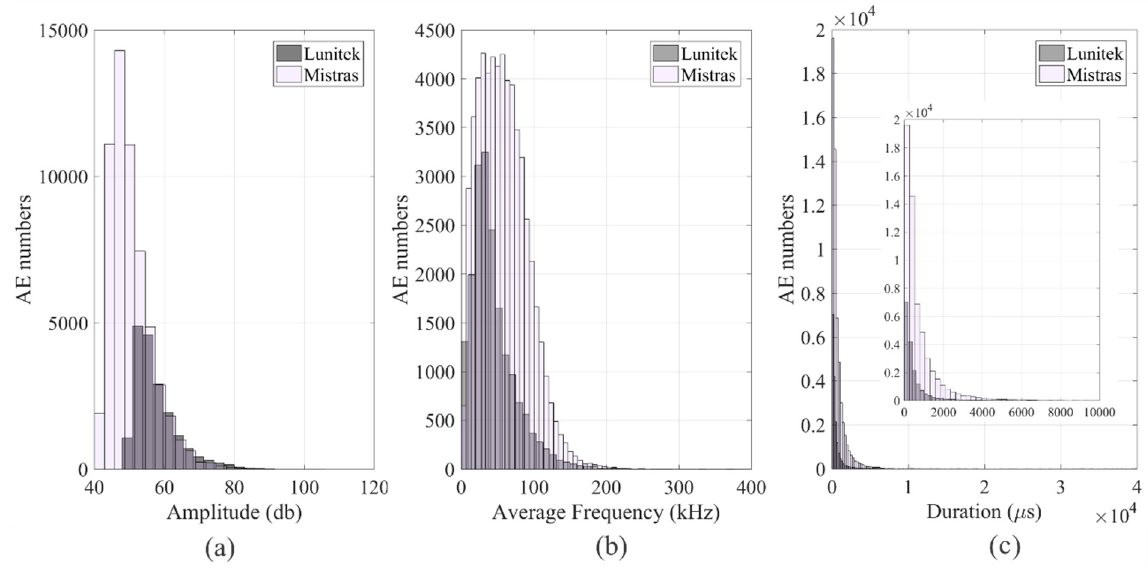
Figure 8. AE parameters statistical analysis for Lunitek and Mistras systems: ( a ) amplitude, ( b ) average frequency, ( c ) duration. Table 1. Coefficient of variation ( CV ), average values ( (cid:104) . (cid:105) ) and standard deviations ( σ ) of the AE signal parameters.